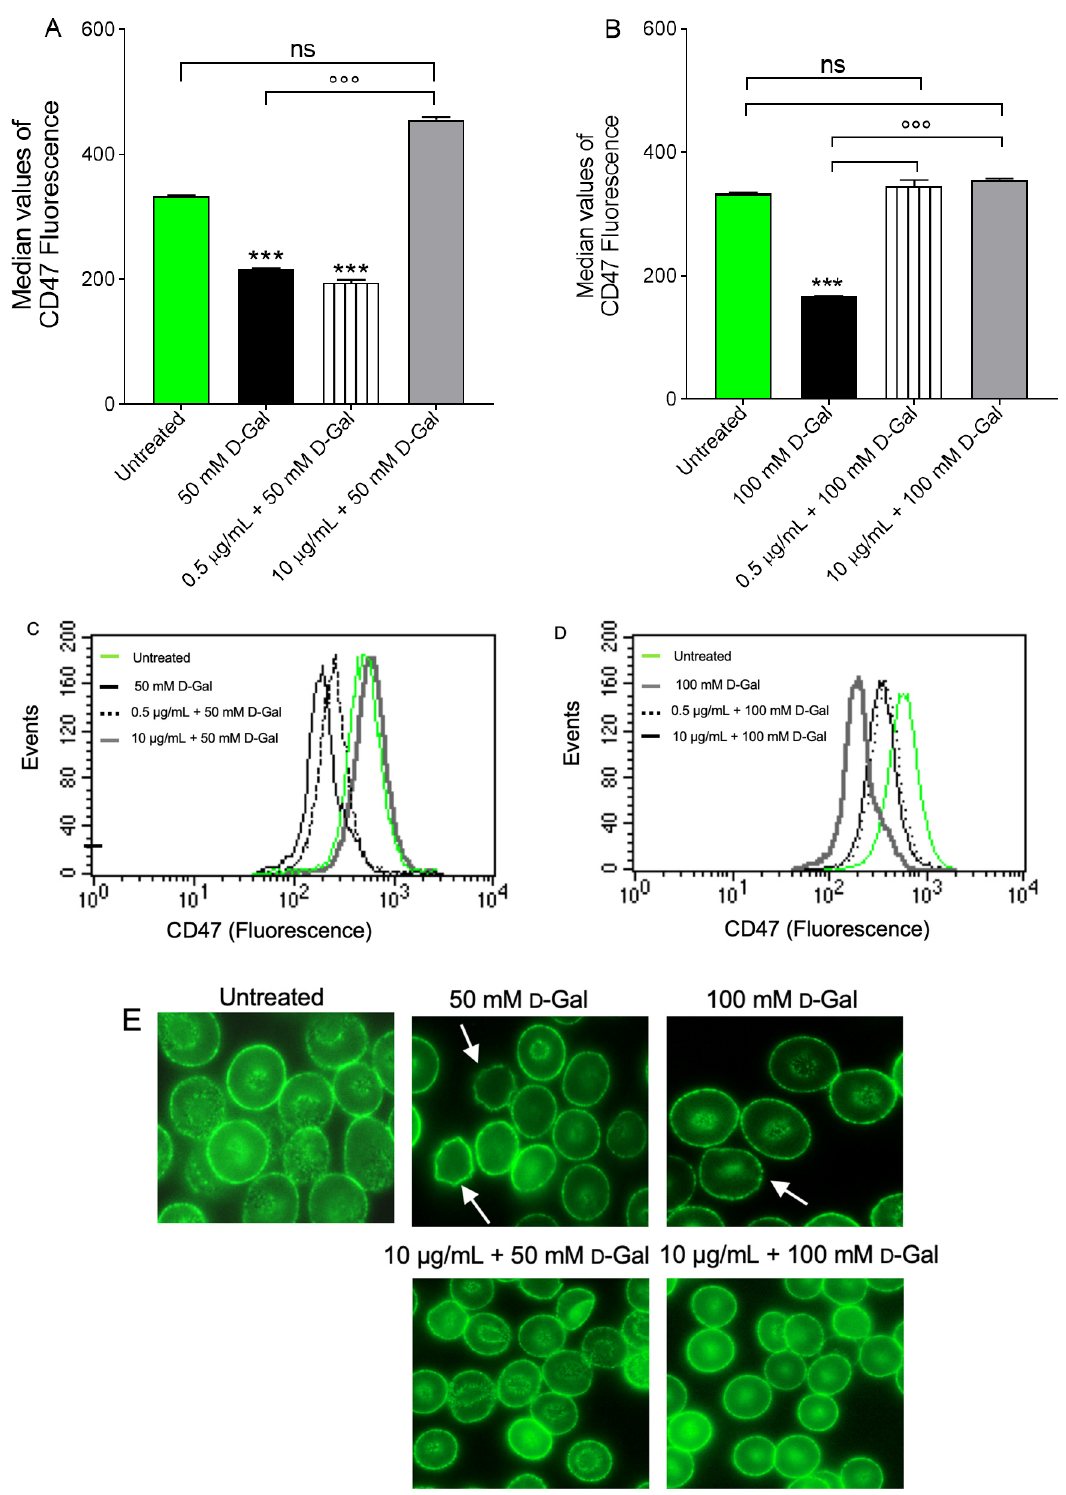
Figure 8. Flow cytometry immunofluorescence of CD47 protein expression. Erythrocytes were treated for 24 h with 50 ( A ) or 100 mM ( B ) D -Gal, with or without pre-incubation for 1 h with 0.5 or 10 µg/mL freeze-dried Açaì extract. Histograms represent median values of fluorescence